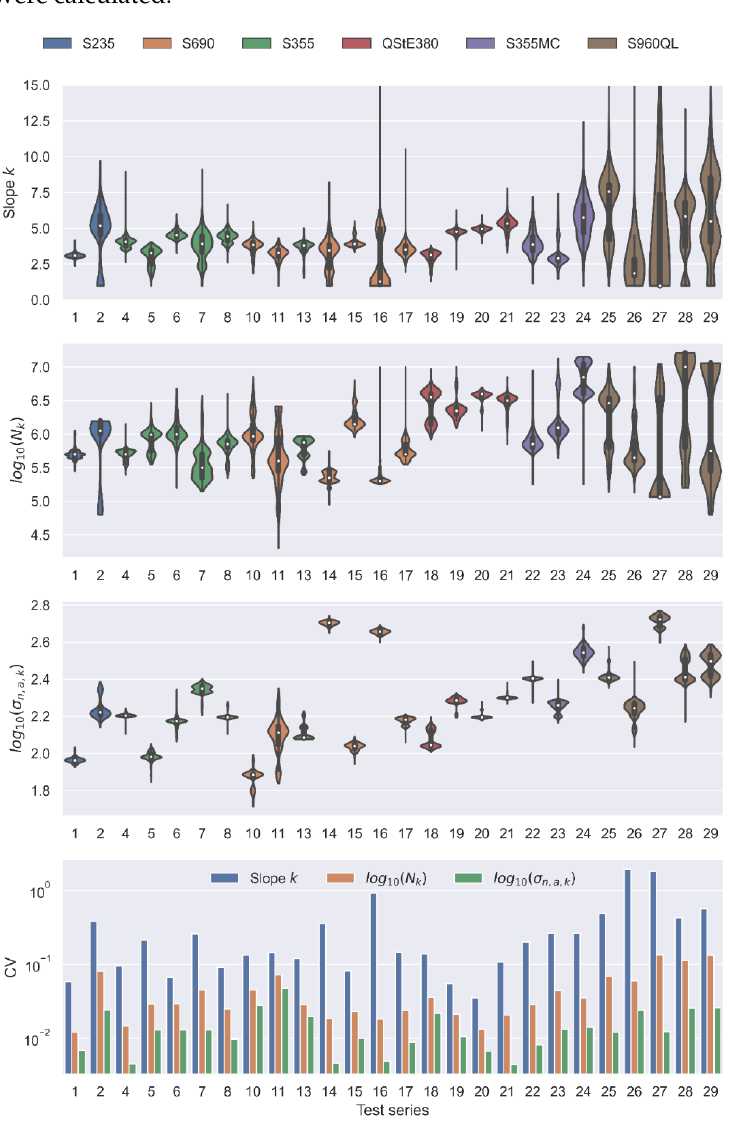
Figure 14. Evaluation of the slope 𝑘 , location of 𝑁 𝑘 , 𝜎 𝑛,𝑘,𝑎 and the coefficient of variation ( 𝐶𝑉 ) of all test series determined by bootstrapping (minimum slope was set to 𝑘 𝑚𝑖𝑛 = 1 ).